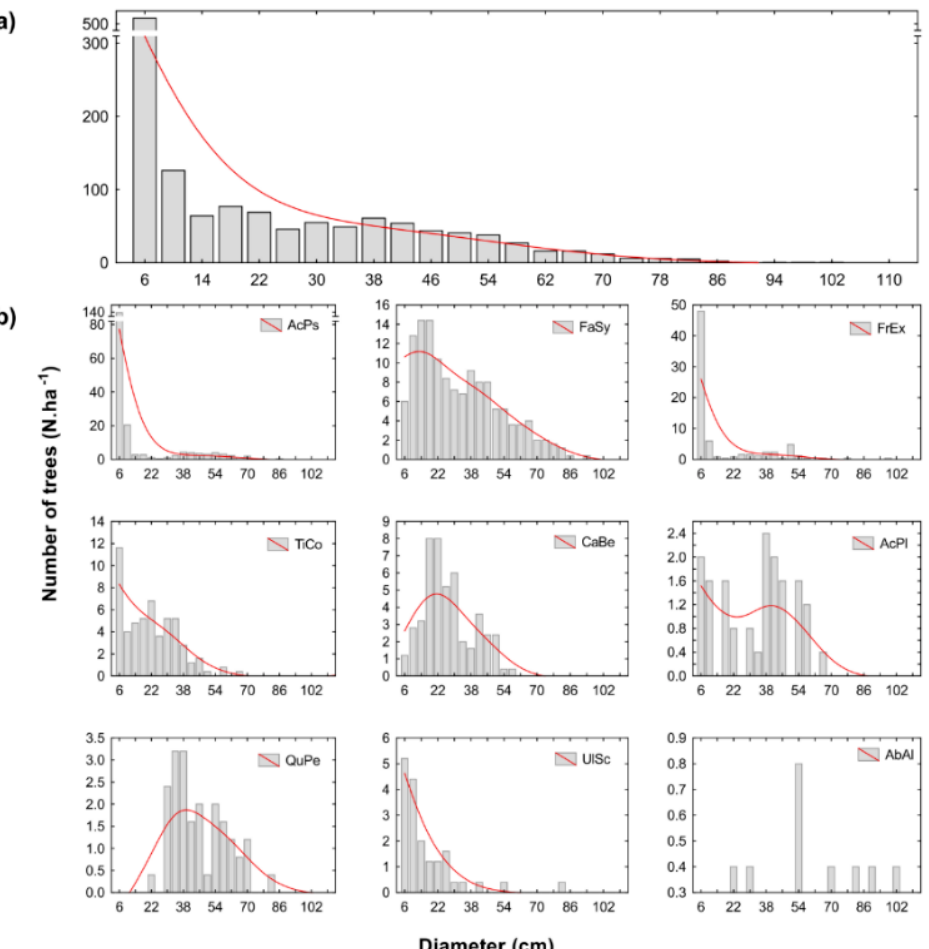
Figure 2. Diameter distributions of ( a ) all and ( b ) individual tree species on the permanent research plot Sitno (trees with dbh > 4 cm). AcPs— A. pseudpolatanus , AcPl— A. platanoides , FrEx— F. excelsior , FaSy— F. sylvatica , TiCo— T. cordata , UlSc— U. scabra , CaBe— C. betulus , QuPe— Q. petraea , AbAl— A. alba.